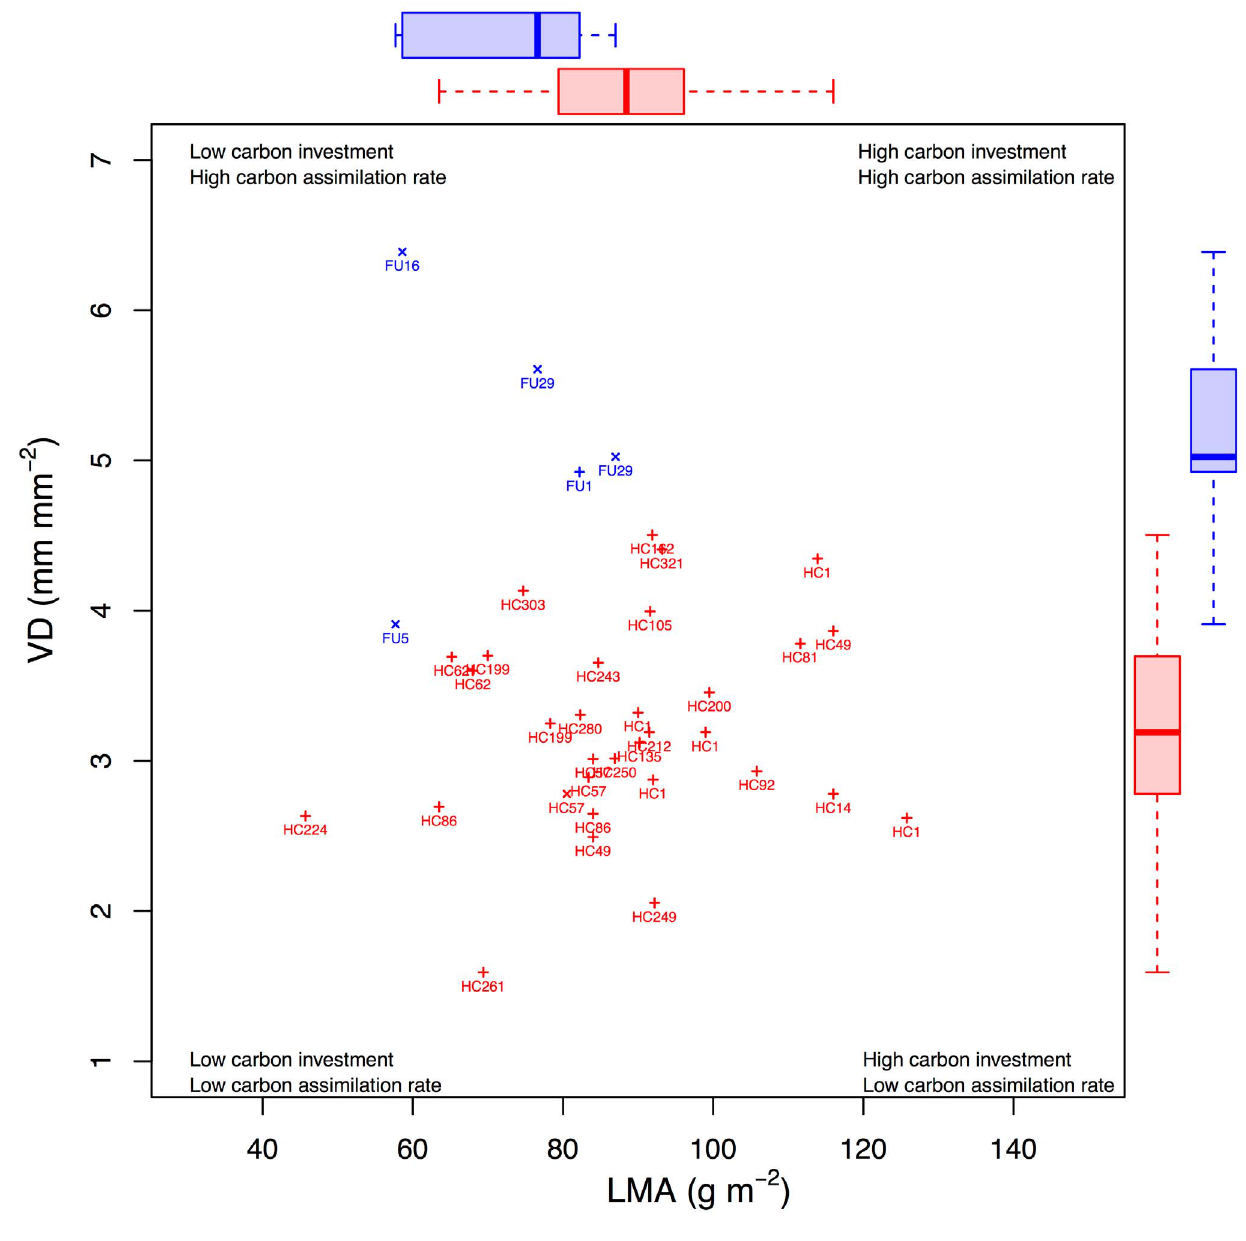
Figure 3. Ecological strategy dynamics across the KPB, as seen in a bivariate trait space of VD and LMA. Points represent individual specimens for which both VD and LMA measurements were available (labeled by morphospecies). Boxplots of each distribution are shown in the margins. Colors and symbols are as in Figure 2.